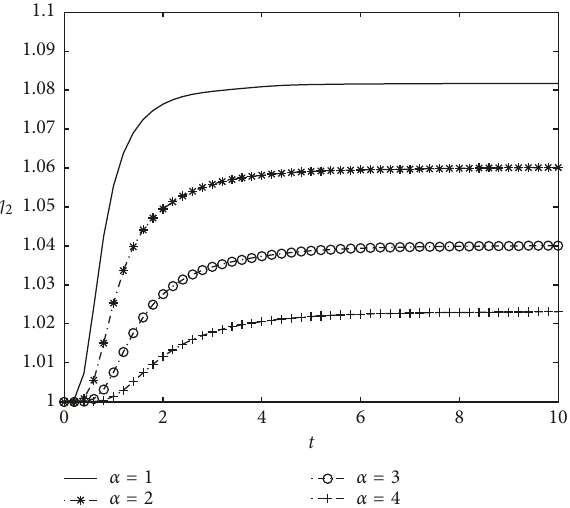
Figure 12: η over time for various values of α when applying the 2 third nonlinear adaptive